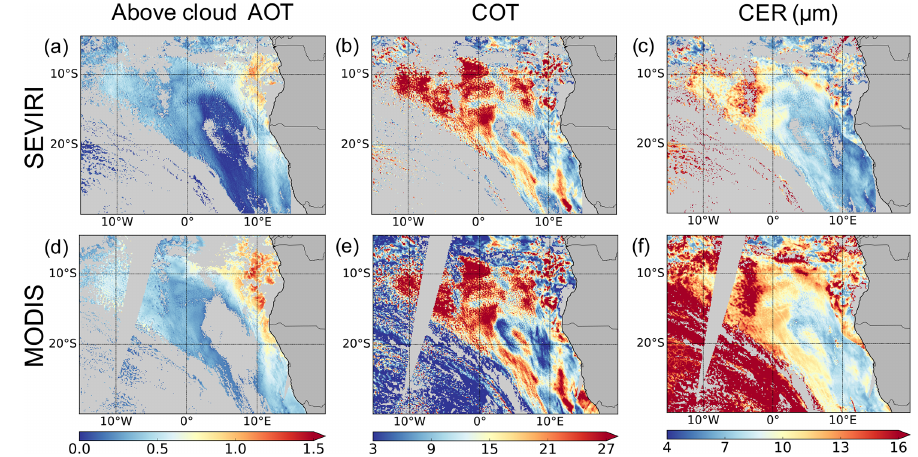
Figure 2. Above-cloud AOT at the 0.55µm optical wavelength and cloud properties retrieved from SEVIRI measurements on 4 September 2017 at 10:15UTC over the SEAO (a–c) and corresponding Terra MODIS observations (10:00UTC for the east overpass and 11:40UTC for the west overpass) from the MOD06ACAERO algorithm (d–f) .